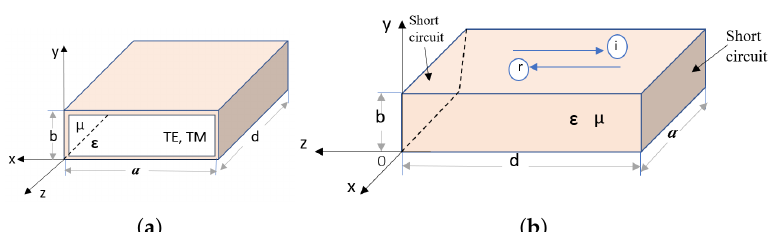
Figure 1. ( a ) rectangular waveguide a > b ; ( b ) rectangular cavity, shorted and perfect electric conductor (PEC) for all sides d > a > b .